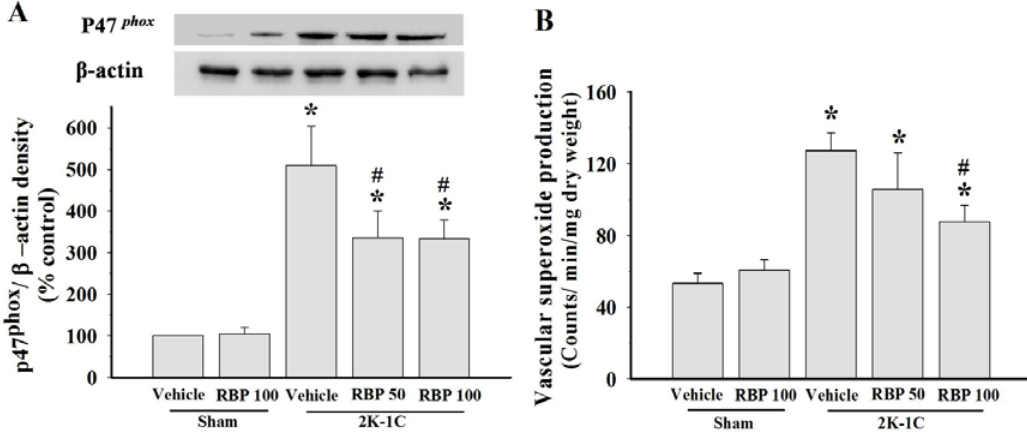
Figure 5. p47 phox protein expression and densitometric analysis in thoracic aortas ( A ) and vascular superoxide production ( B ) in all experimental groups. Data are mean values ± SEM; ( n = 8/group), * p < 0.05 vs. sham-operated group, # p < 0.05 vs. 2K-1C group and † p < 0.05 vs. 2K-1C + RBP50 group; Rice bran peptides, RBP.